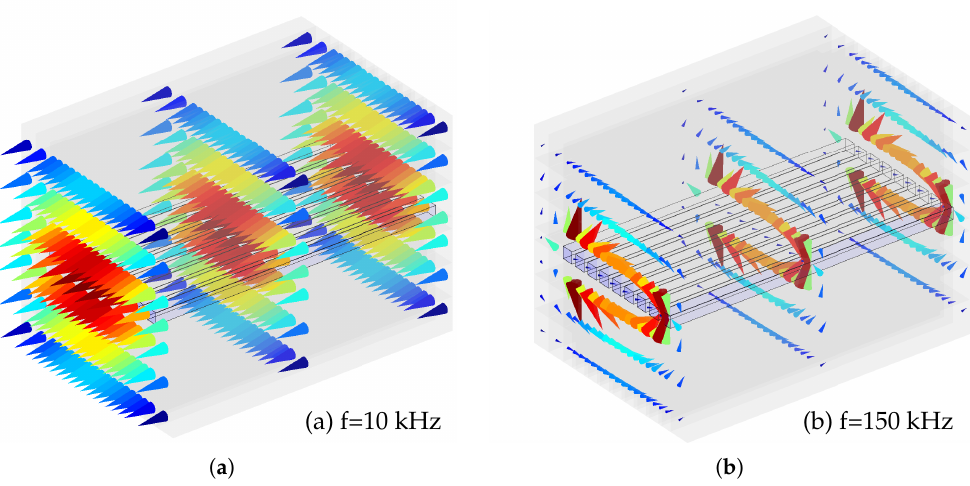
Figure 12. PEEC model simulation: distribution of J e in the concrete. Inductive component predominant ( a ); capacitive component predominant ( b ). ( a ) and ( b ) not in the same